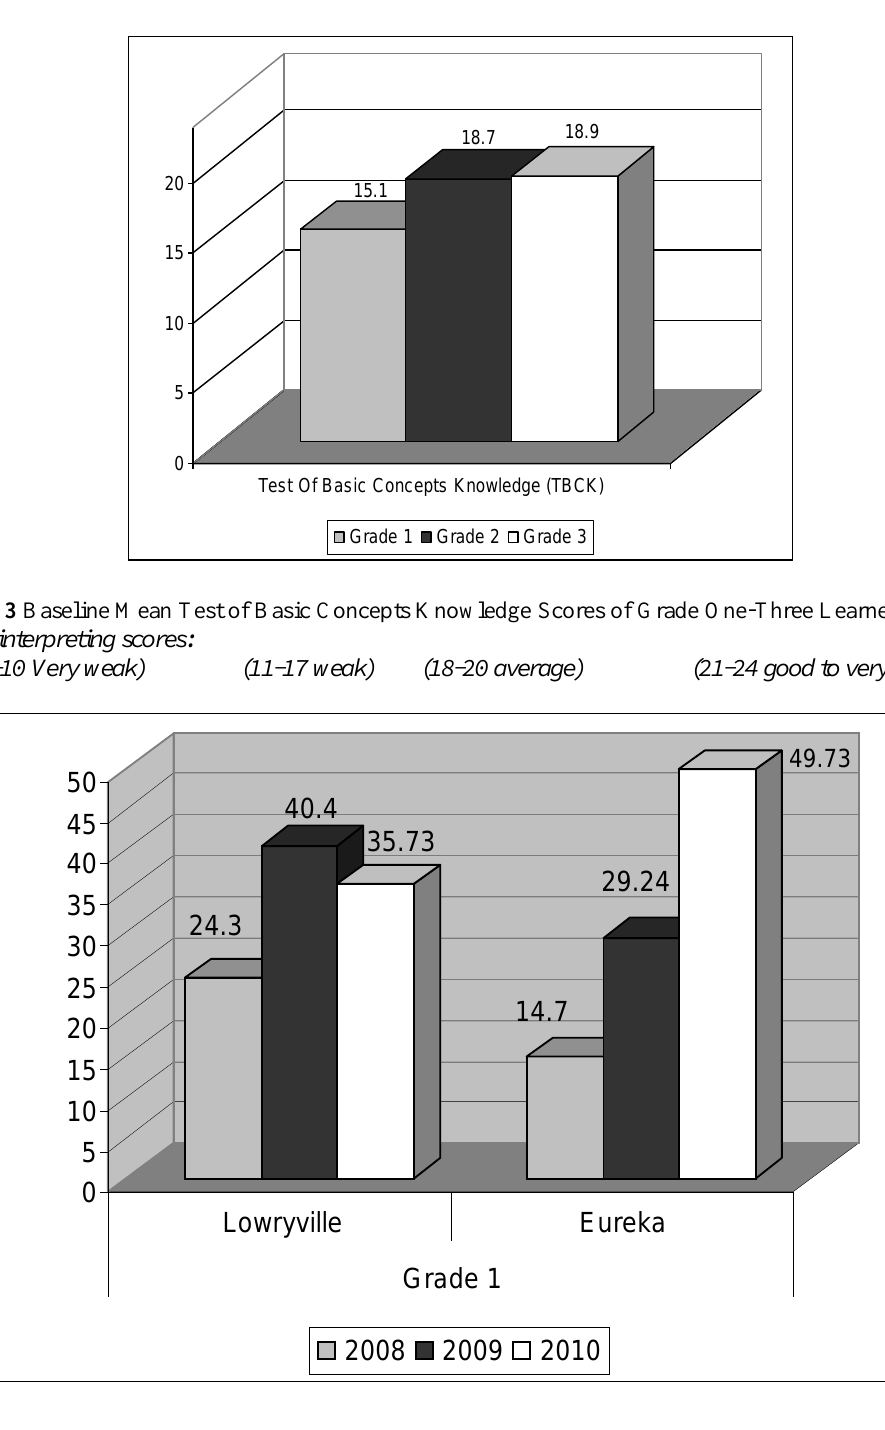
Figure 4 Mean Scholastic Scores for Grade One from 2008 to